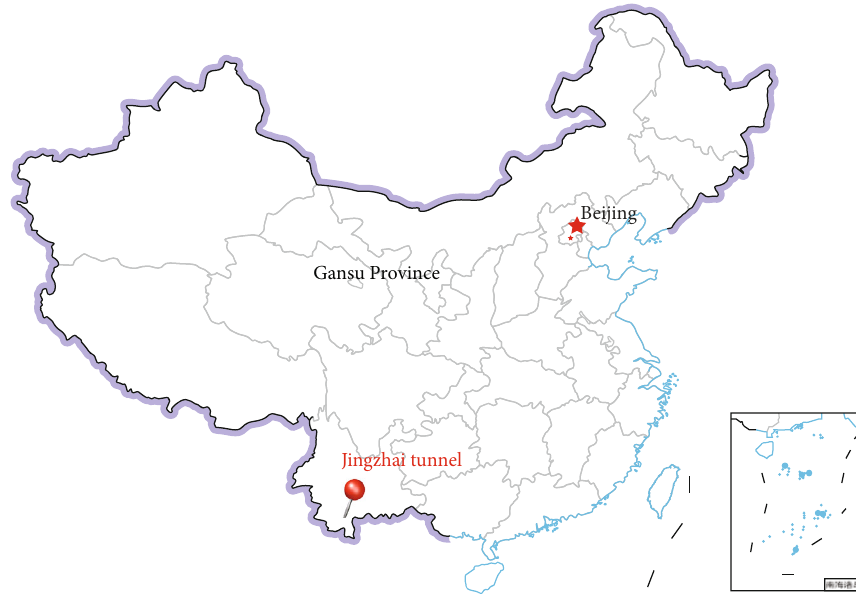
Figure 1: Location of Jingzhai